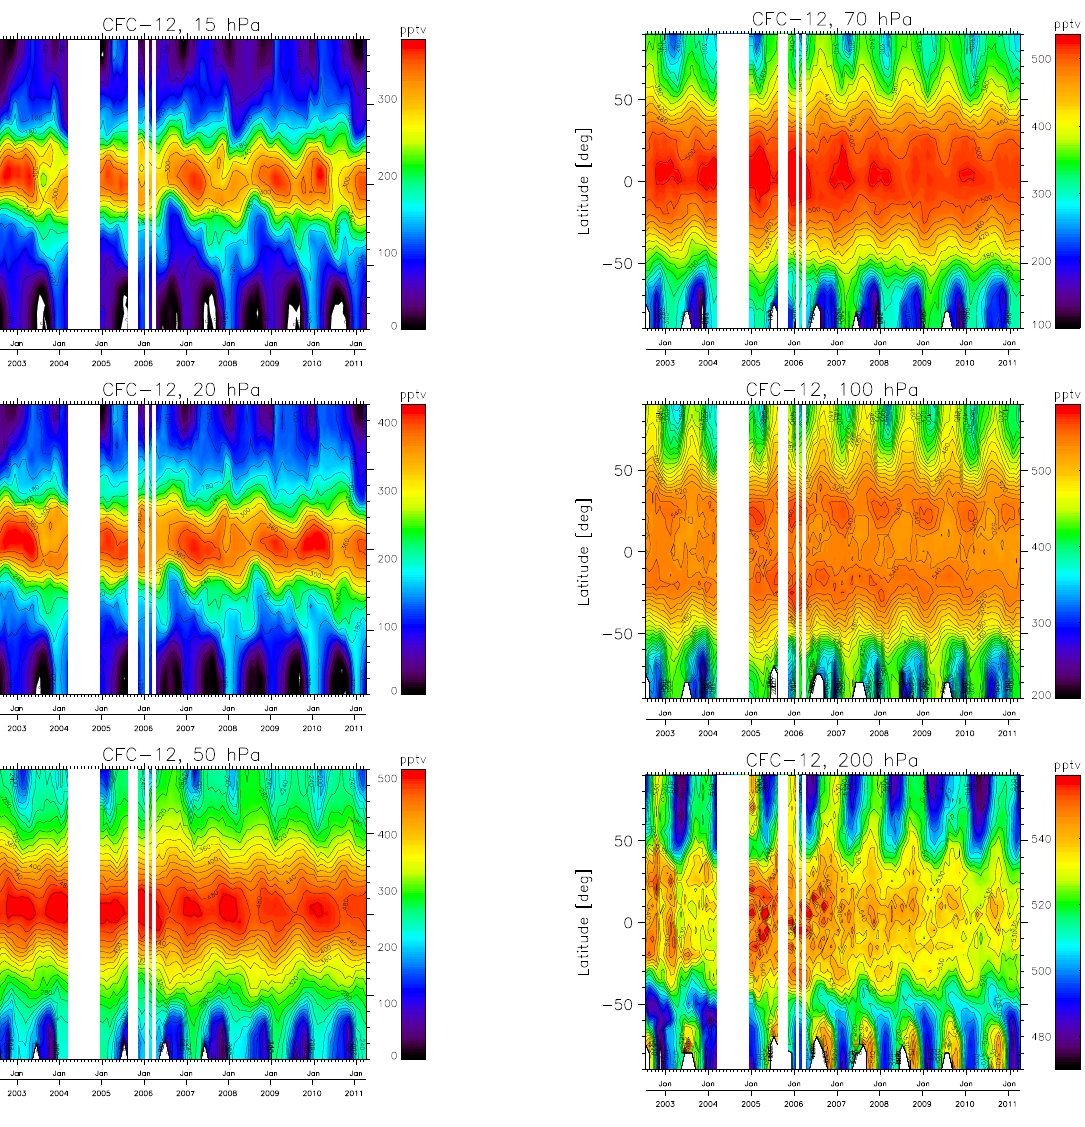
Fig. 10. Time series of CFC-12 as a function of latitude between July 2002 and April 2011 at 70 hPa, 100 hPa and 200 hPa. Details as for Figure 7.